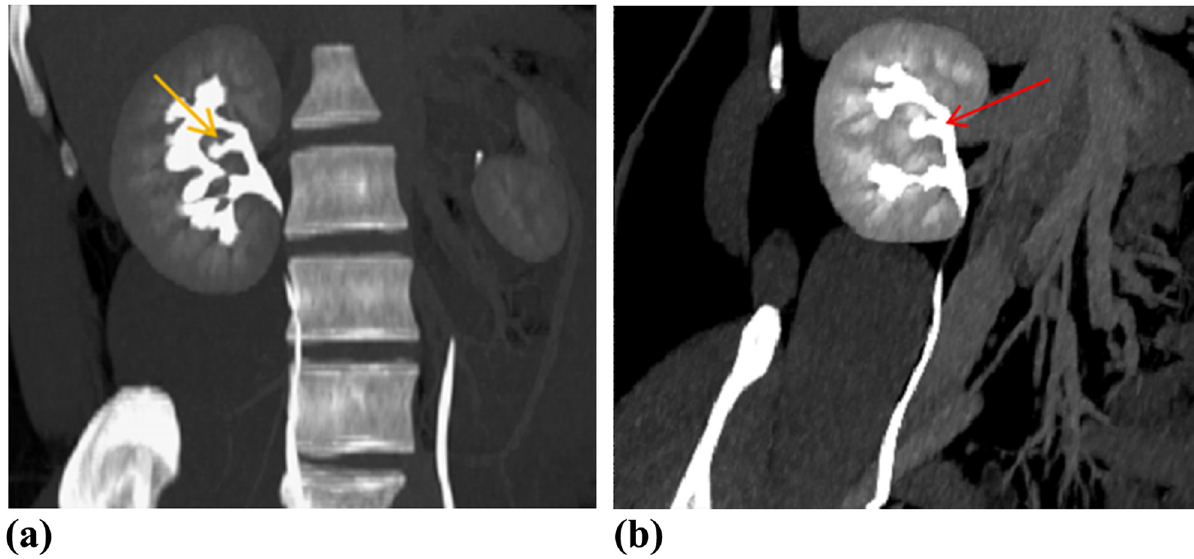
Figure 3: Pyelographic phase coronary MIP ( a ) and CPR ( b ) images demonstrated that the little renal pelvis ( yellow arrow ) from renal shaped mass in the renal sinus drained into the calyces of the upper pole of right kidney ( red arrow ) . MIP = maximum intensity projection; CPR = curved planar